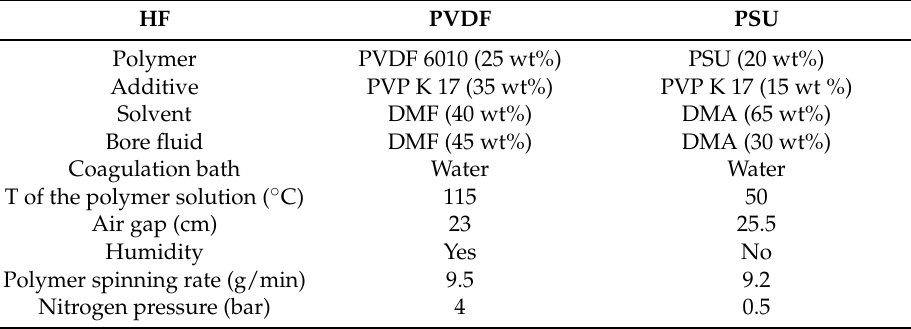
Table 1. Composition of the polymer solution and spinning conditions. HF